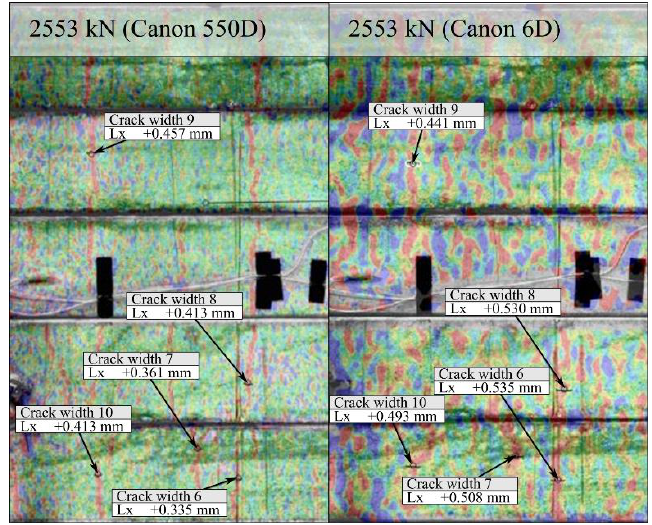
Figure 20. Crack widths at crack detection for Strip 2. Table 4. Measured and corrected crack widths at crack detection—Strip 2. Crack No. Strip No.